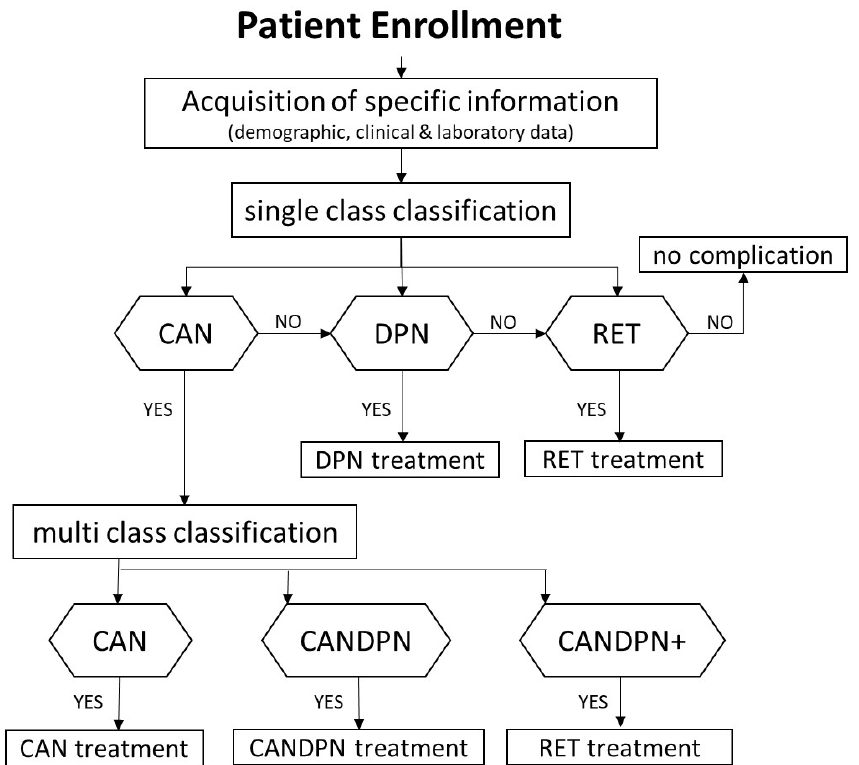
Figure 2. The proposed procedure for screening diabetic patients. Every patient initially goes through the information acquisition of this clinical diagnosis flowchart. Five tests are then applied in two stages. The second stage (multiclass class is only for the patients who go through the CAN test and have a positive CAN. A single-class classification can predict the presence of microvascular complications (CAN, DPN, or RET) and can predict whether there is any presence of complications. Multiple complications with CAN could be classified using the multiclass classifier.